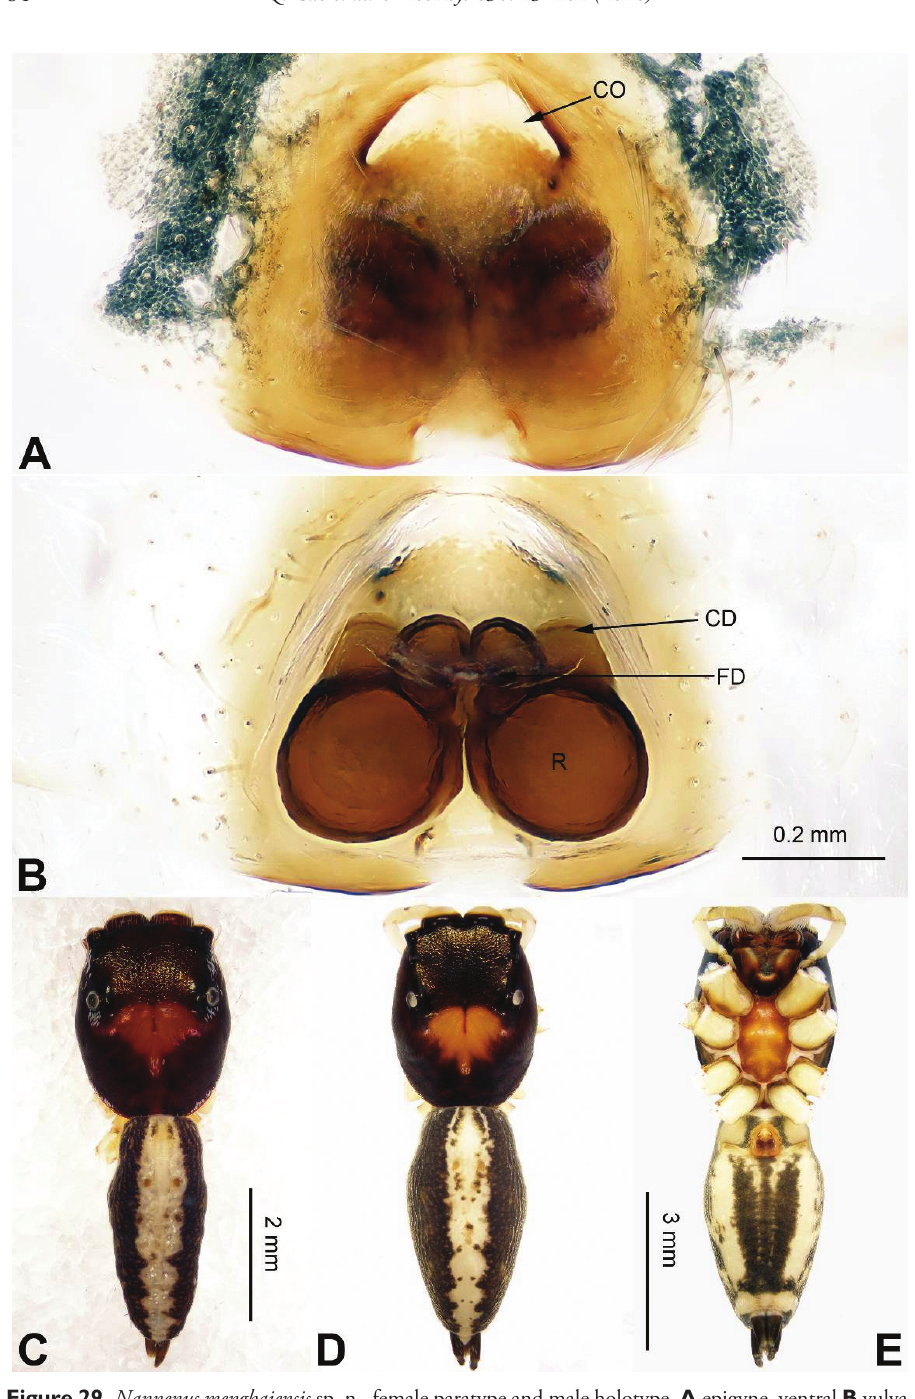
Figure 29. Nannenus menghaiensis sp. n., female paratype and male holotype. A epigyne, ventral B vulva, dorsal C male habitus, dorsal D female habitus, dorsal E female habitus, ventral. Scale bars equal for A and B ; equal for D and E